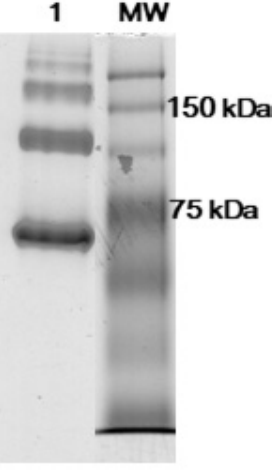
® AFP. MW, molecular weights.